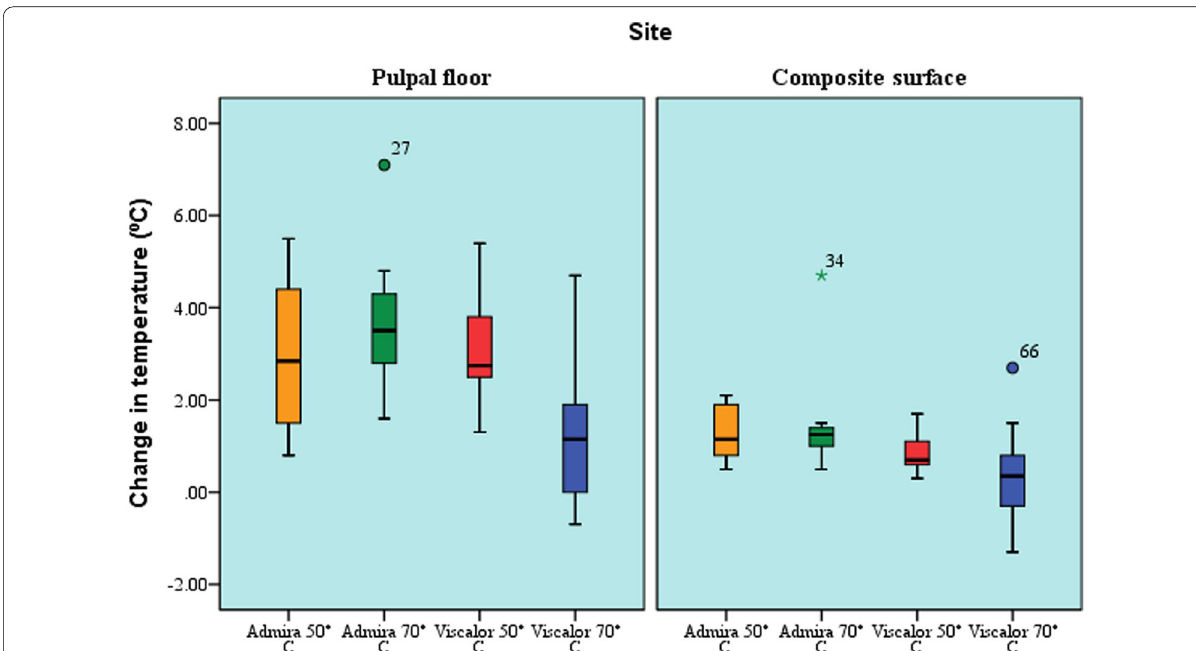
Fig. 4 The median and range values for temperature changes in distinct groups are represented by a box plot (circles and star represent